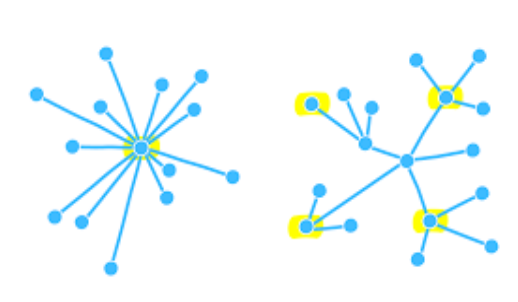
Fig.1 Centralized and Decentralized